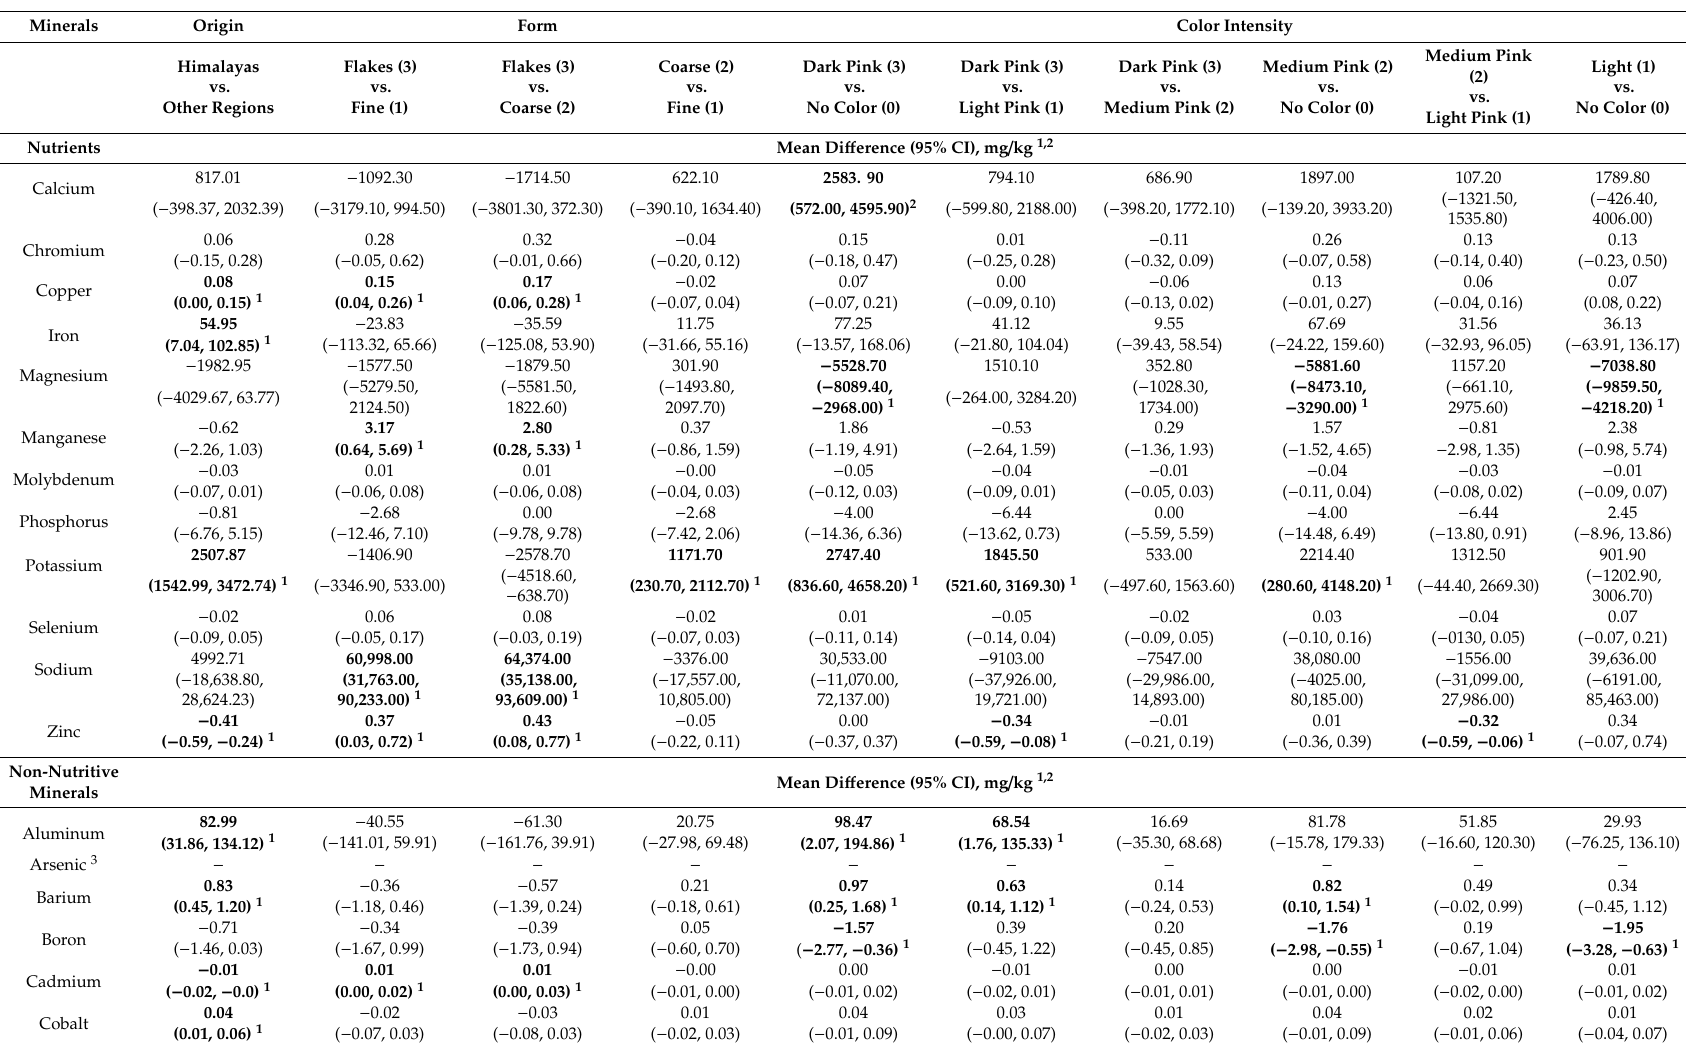
Table 5. Impact of origin, form, and color intensity on the mineral content of pink salt samples which were purchased from retail stores in Australia in June 2018.